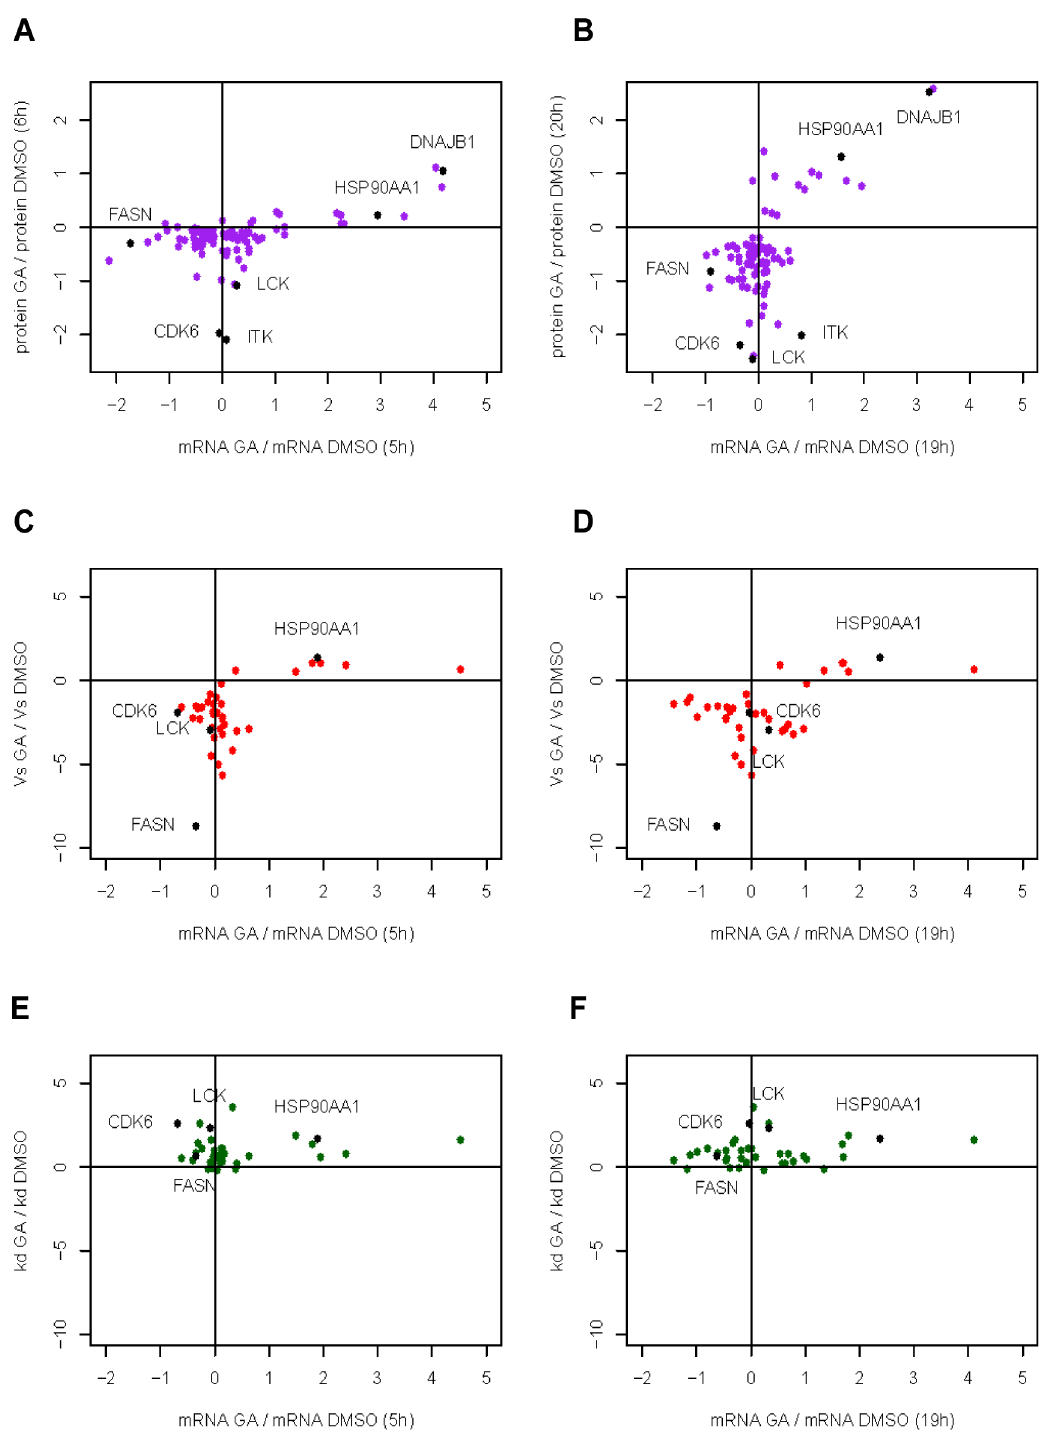
Figure 8. Dynamic changes in mRNA levels and net protein abundances (stSILAC), protein synthesis, or decay (pcSILAC) rates for a selection of transcripts/proteins from several clusters upon Hsp90 inhibition. Plots show data derived from stSILAC (A and B) and from pcSILAC experiment 2 (C, D, E, and F). A ) Variations in mRNA (log 2 fold-change) versus protein levels at 5-6h. B ) Variations in mRNA (log 2 fold-change) versus protein levels at 19-20h. C ) Plot describing the variations in mRNA (log 2 fold-change) at 5h versus protein synthesis rates (log 2 [V s_GA /V s_DMSO ]). D ) same as C) but mRNA at t=19h. E ) Plots describing the variations in mRNA (log 2 fold-change) at 5h versus decay rates (log 2 [k s_GA /k s_DMSO ]). F ) same as E) but at t=19-20h. A selection of transcripts encoding Hsp90, cofactor DNAJB1, Hsp90 clients Cdk6, Lck, FASN and the novel potential Hsp90 client ITK, are labelled.